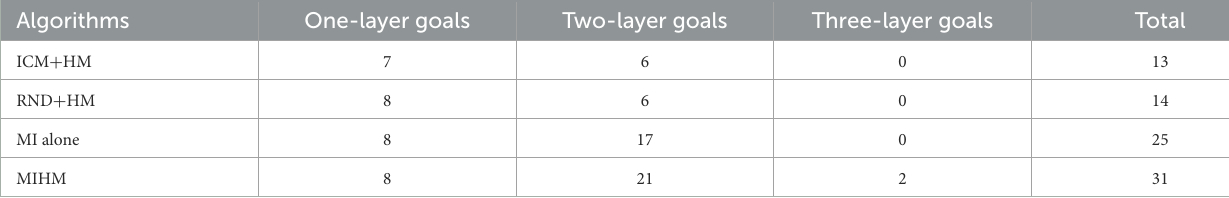
TABLE 3 The number of finally learned goals (whose success rates are > 80%) in each goal category for ICM + HM, RND + HM, MI alone and MIHM. Algorithms One-layer goals Two-layer goals